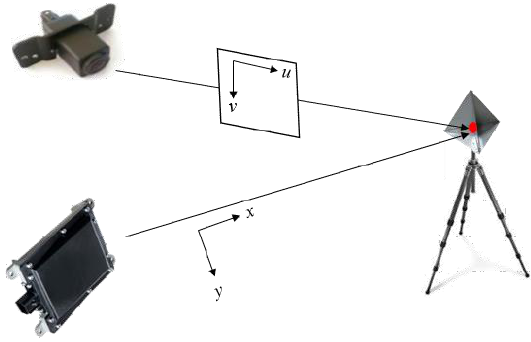
Figure 8. Coordinate transformation of data from the radar and camera.